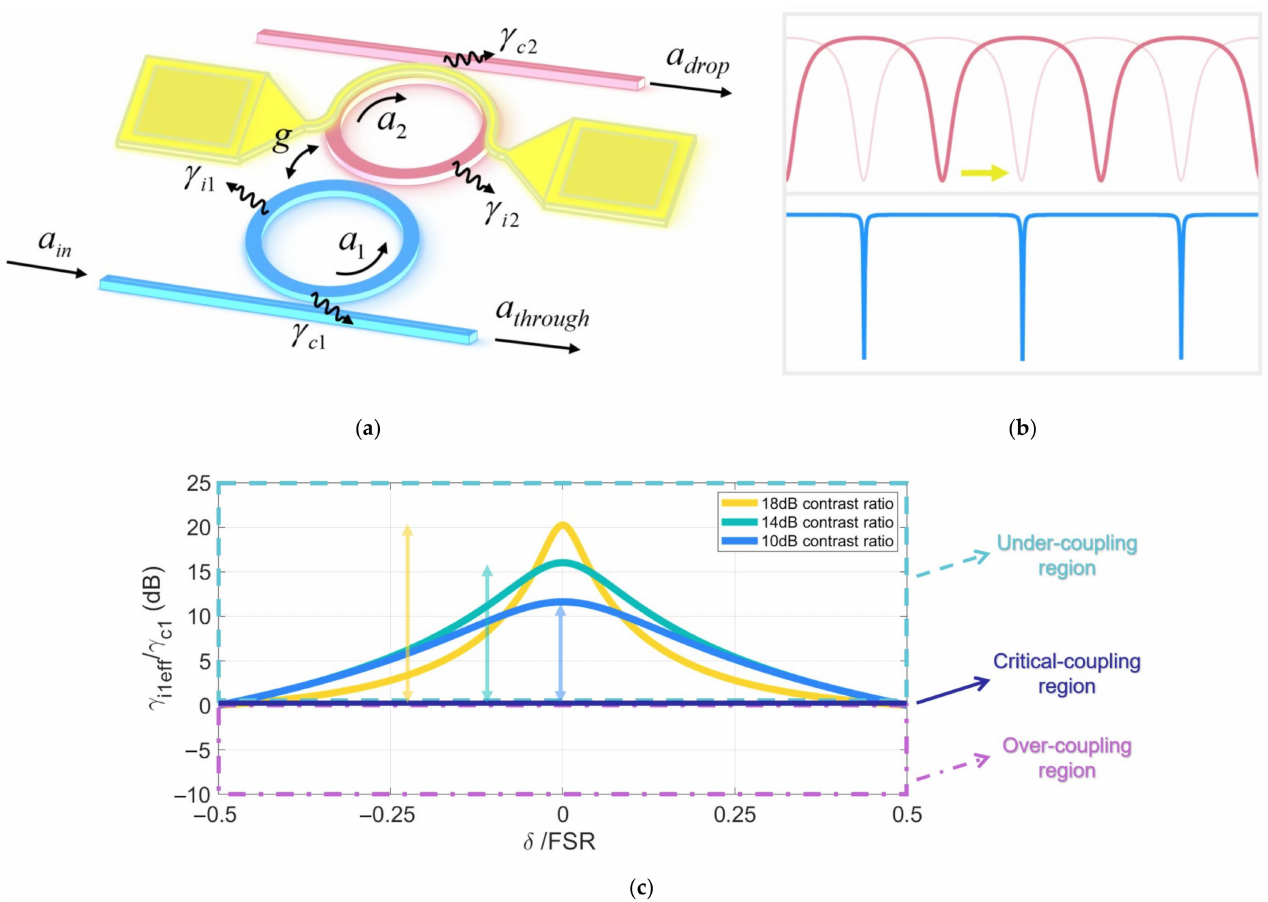
Figure 1. Parity-time (PT) symmetry enabled bandwidth-tunable band-pass filter with the trade-off between the bandwidth tunable contrast ratio and insertion loss. ( a ) Schematic diagram of the proposed coupled resonant device structure. ( b ) Schematic of adjusting detuning between two rings. ( c ) Evolution of the ratio of the effective propagation loss to the coupling loss of the main cavity ( γ i 1 ef f / γ c 1 ) as a function of the detuning δ / FSR